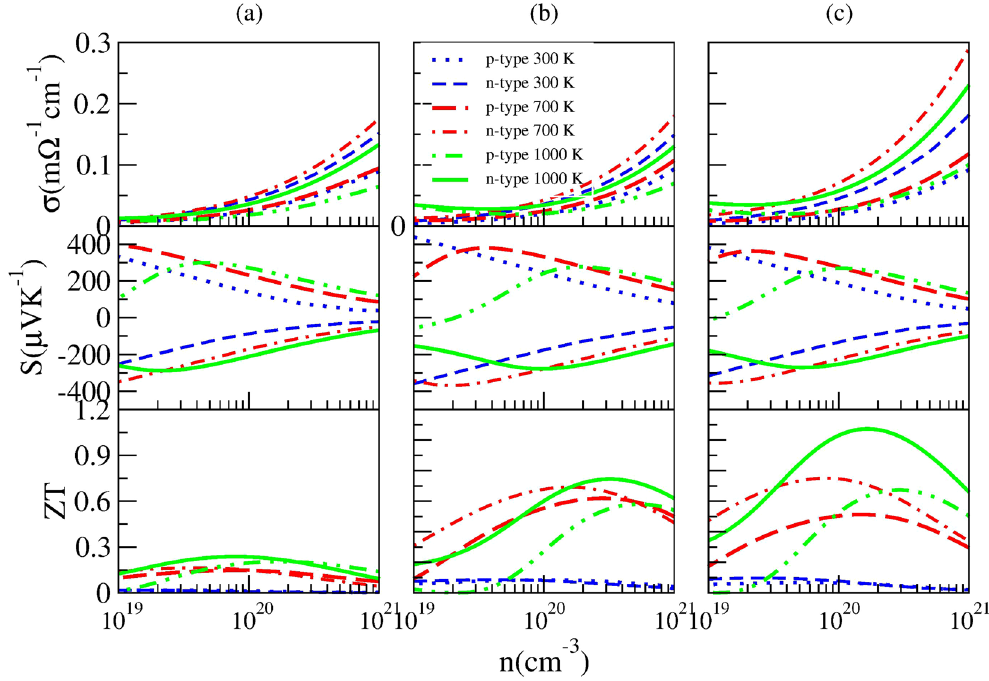
Figure 7. Calculated transport properties of p -type and n -type ZrNiSn ( a ), Hf 0.25 Zr 0.75 NiSn ( b ), and Hf 0.5 Zr 0.5 NiSn ( c ), respectively.